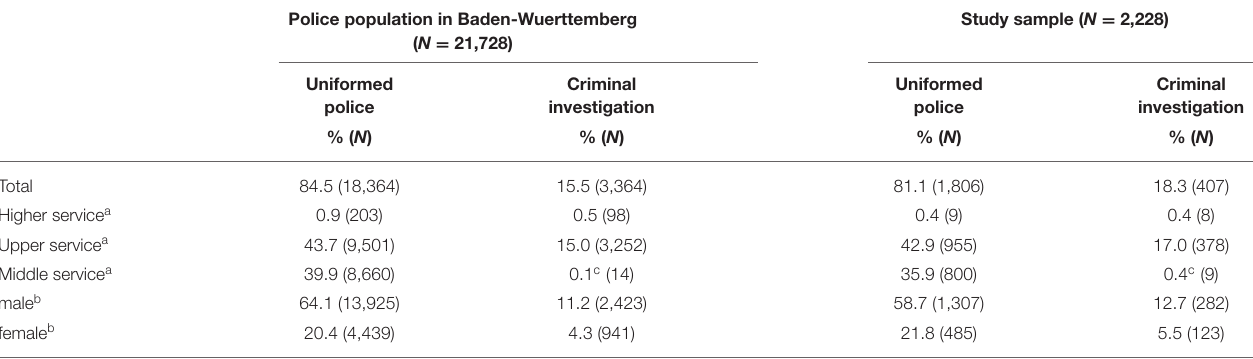
TABLE 1 | Relation between overall police population in Baden-Wuerttemberg and study sample divided into uniformed and criminal investigation division and in regard to career path (middle, upper, higher), as well as sex (male, female). Police population in Baden-Wuerttemberg ( N = 21,728)